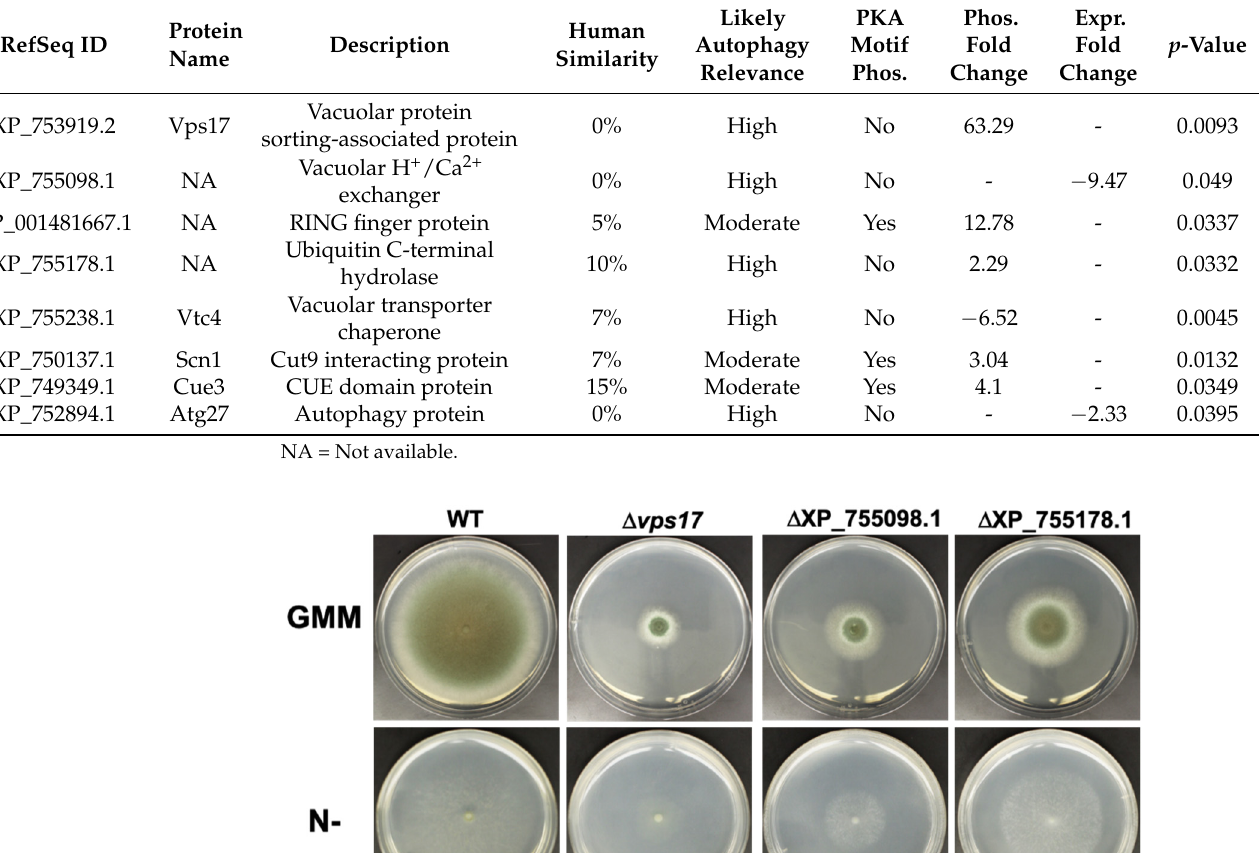
Table 3. Prioritized PKA-regulated autophagy-associated proteins.